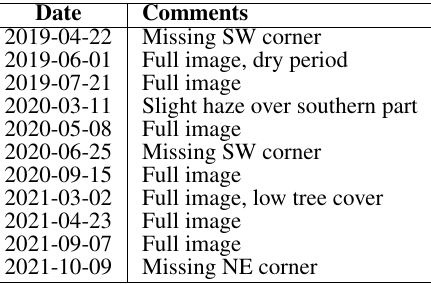
Table 2. Superview-1 data used in this study. Comments are based on visual